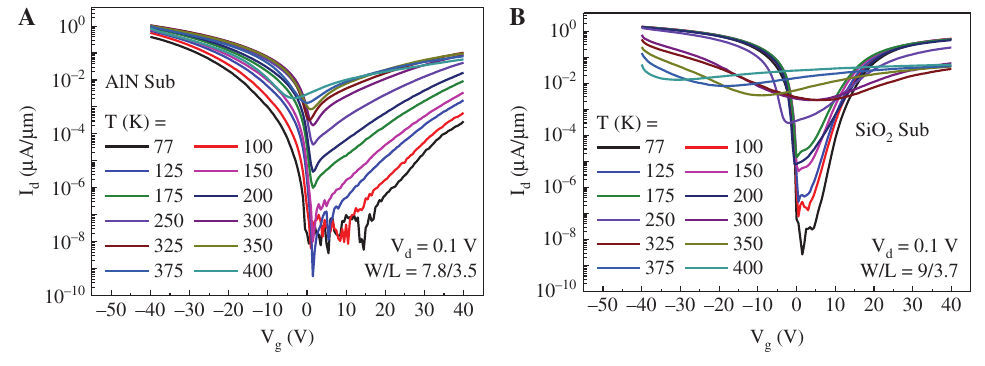
Figure 2: Temperature dependent electrical characteristics of BP FETs on two substrates. I - V characteristics as a function of temperature from 77 to 400 K for BP FETs on (A) AlN/SiO d g